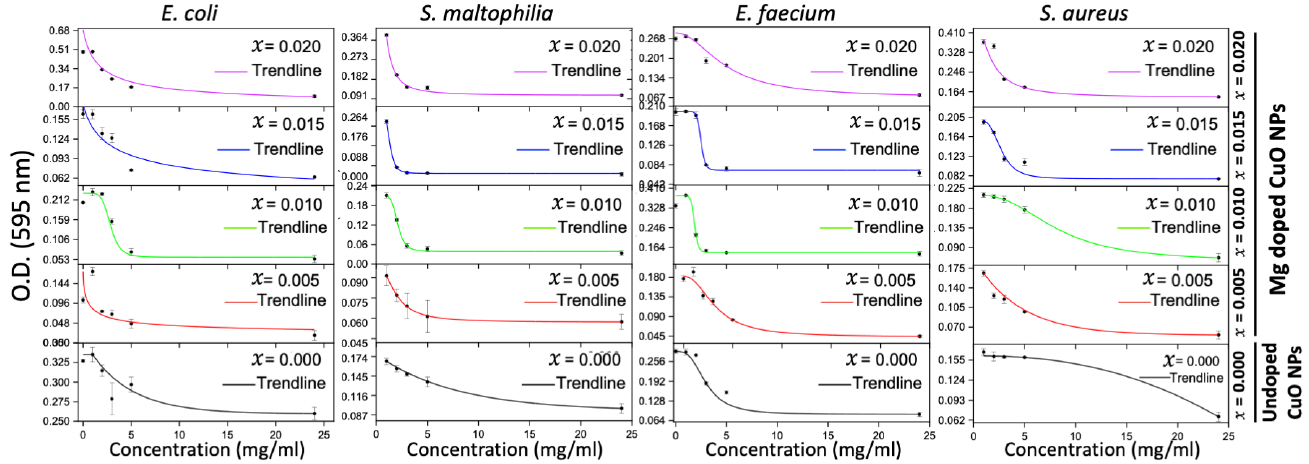
Figure 6. Time-kill results of the undoped and Mg-doped NPs against four bacterial isolates.